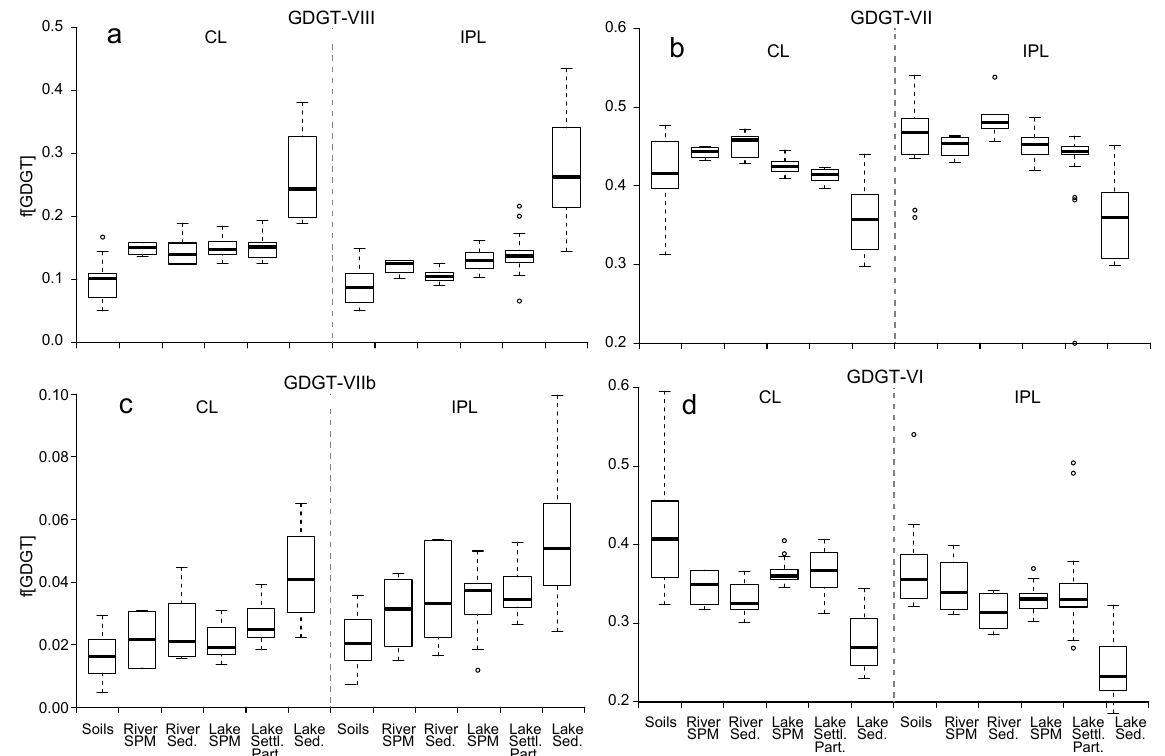
Figure 6. Boxplots of fractional abundances of (a) GDGT-VIII, (b) GDGT-VII, (c) GDGT-VIIb and (d) GDGT-VI in different sample groups for both IPLs and CLs; Note the differences of scale on the y axes. The box corresponds to the interquartile range (25–75%), and the whiskers extend to 1.5 times the interquartile range (unless the full range of data is smaller than this); outliers are defined here as being outside the maximum extent of the whiskers. The black horizontal line inside the box represents the